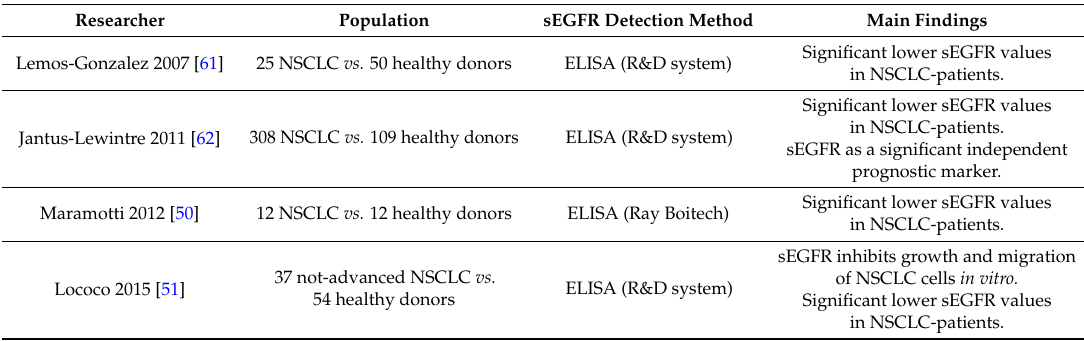
Table 1. Overview of the relevant literature concerning the role of sEGFR in